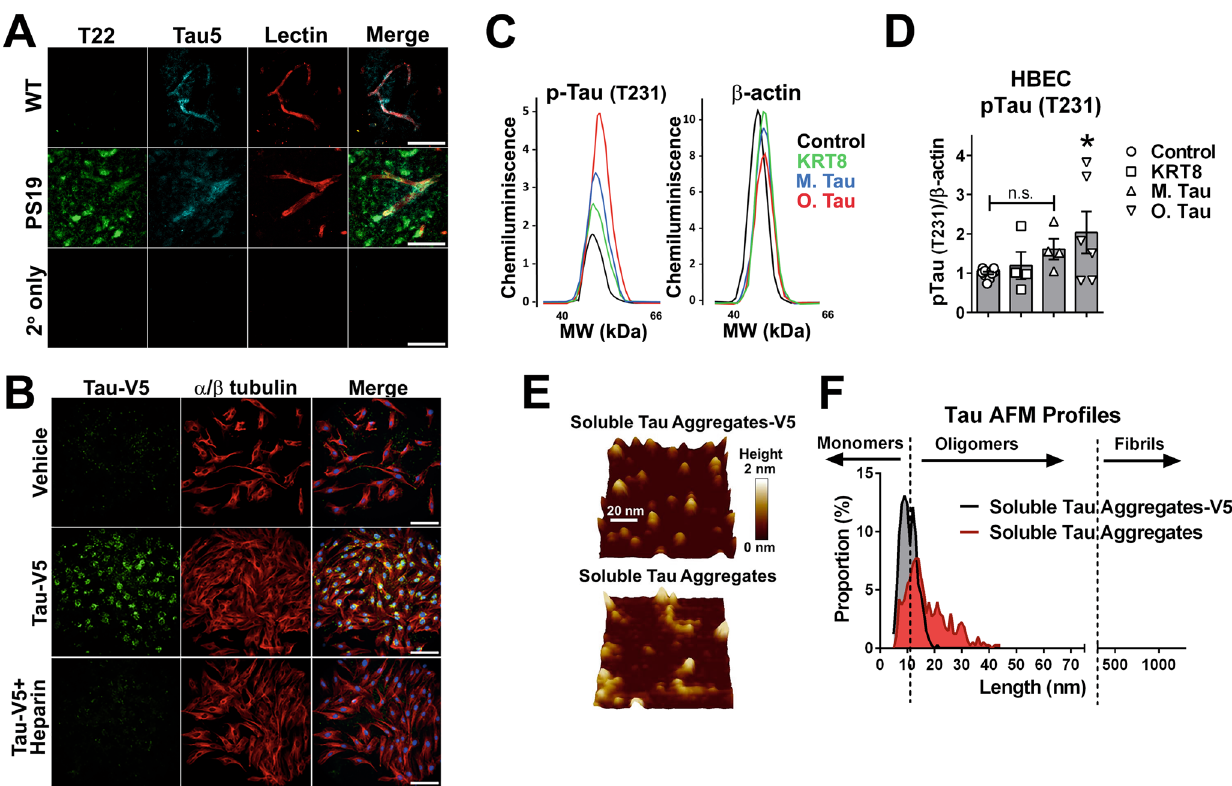
Fig. 1 | Heparan sulfate proteoglycan (HSPG)-dependent internalization of soluble extracellular tau aggregates by brain microvascular endothelial cells triggers endogenous tau phosphorylation(Thr231).A – C Soluble aggregated tau internalization triggers endogenous tau phosphorylation in primary human brain microvascularendothelialcells(HBEC). A Solubletauaggregatesaccumulateinbrain microvasculature of P301S(PS19) mice. Representative images of cortical brain sec- tions from 8-month-old male and female P301S(PS19) and WT controls showing soluble tau aggregates (T22, green) and total tau (Tau5, cyan) immunoreactivity in lectin-stained microvasculature (red). Nine independent samples (three brain sec- tions from each of three mice) were examined over three independent experiments. B Representative images of primary HBEC exposed to soluble aggregates of V5- taggedrecombinanthumantau-441orvehicle(control)inthepresenceorabsenceof heparin, immunostained with antibodies for V5 (green) and α / β -tubulin (red), and counterstainedwithDAPI(blue).Scalebaris200 µ m.Nineindependentsampleswere examined over 3 independent experiments. C Representative electropherograms